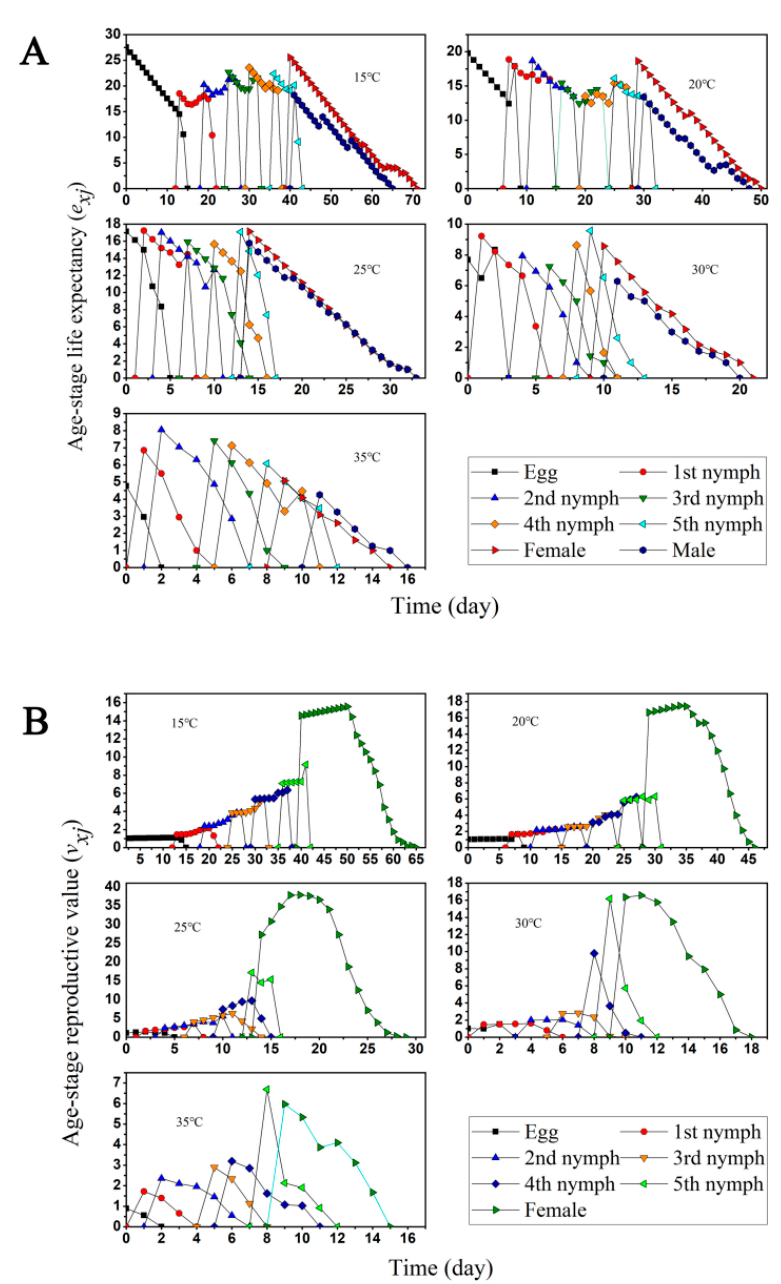
Figure 4. ( A ) Age-specific life expectancy ( e xj ) and ( B ) age-stage reproductive value ( v xj ) at five different temperatures.